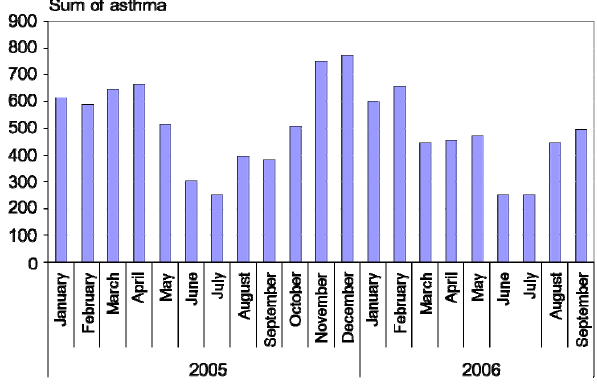
Fig. 7. Asthma incidences by month within five miles of PM 10 monitoring sites.